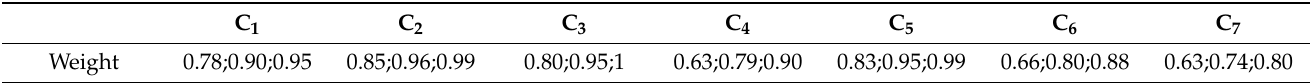
Table 8. Fuzzy weights of decision